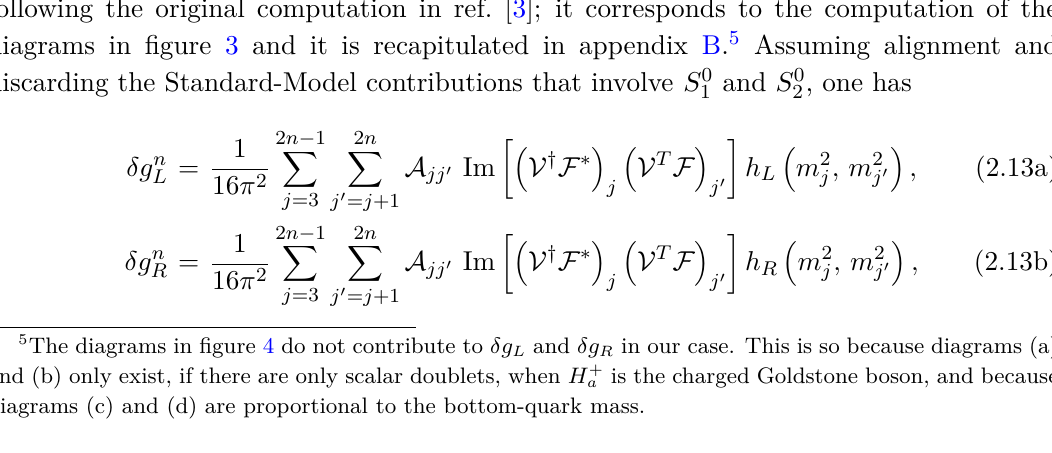
Figure 3 . Feynman diagrams that produce equations (2.13) and